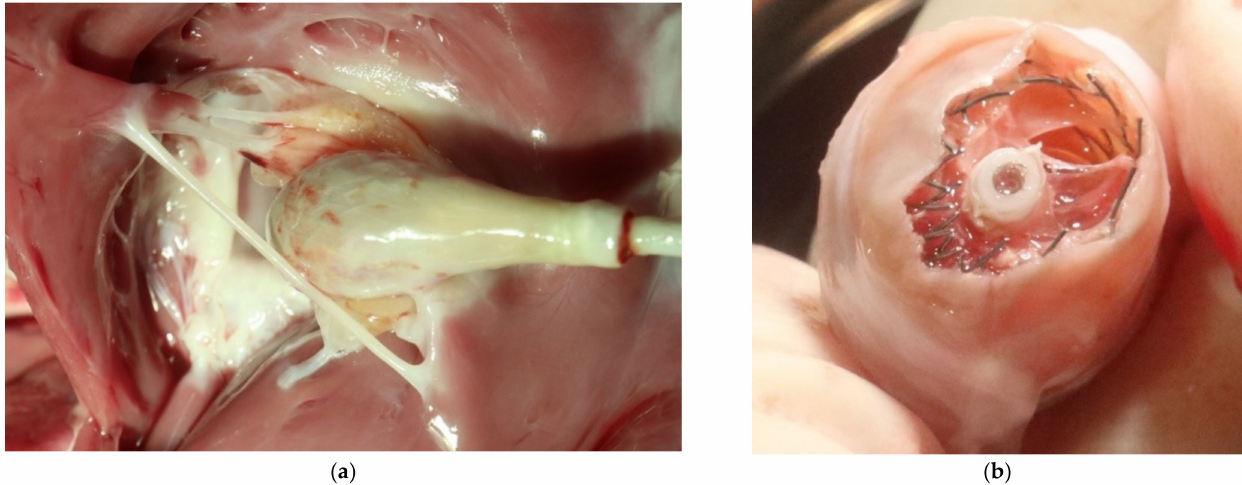
Figure 3. Gross estimation. ( a ) A smooth cell layer was formed over the ePTFE coating. The anterior leaflet, which has the most contact with the device, was slightly thicker than the other. ( b ) A seroma-like material was formed inside the self-expandable nitinol